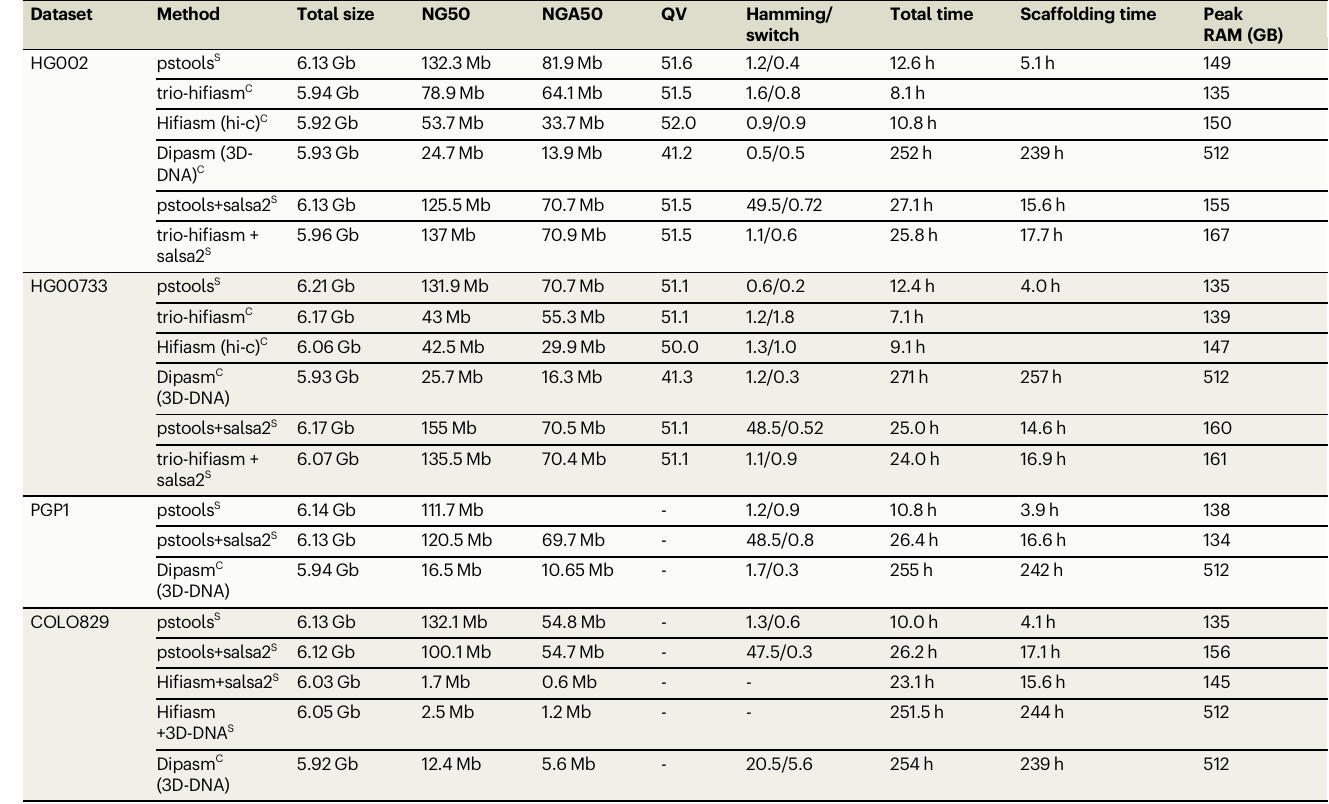
Table 1 | Evaluation statistics of phased sequences